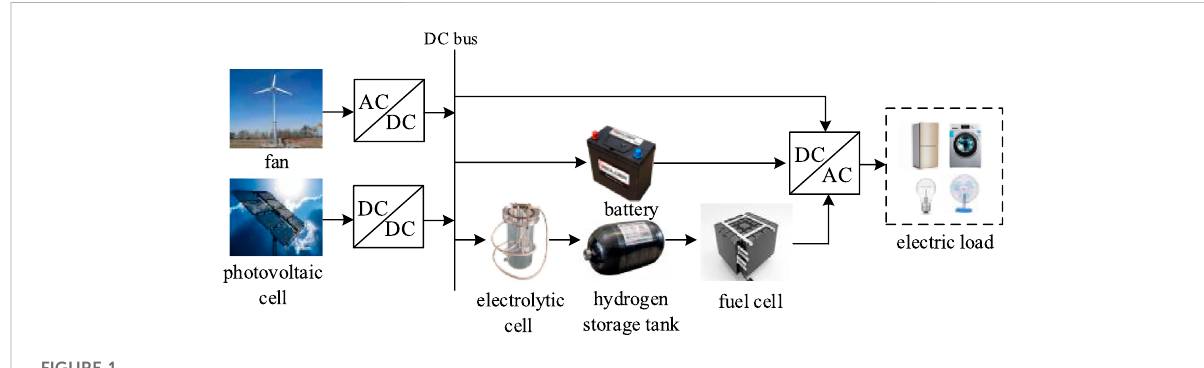
FIGURE 1 Independent wind-photovoltaic-hydrogen-battery system